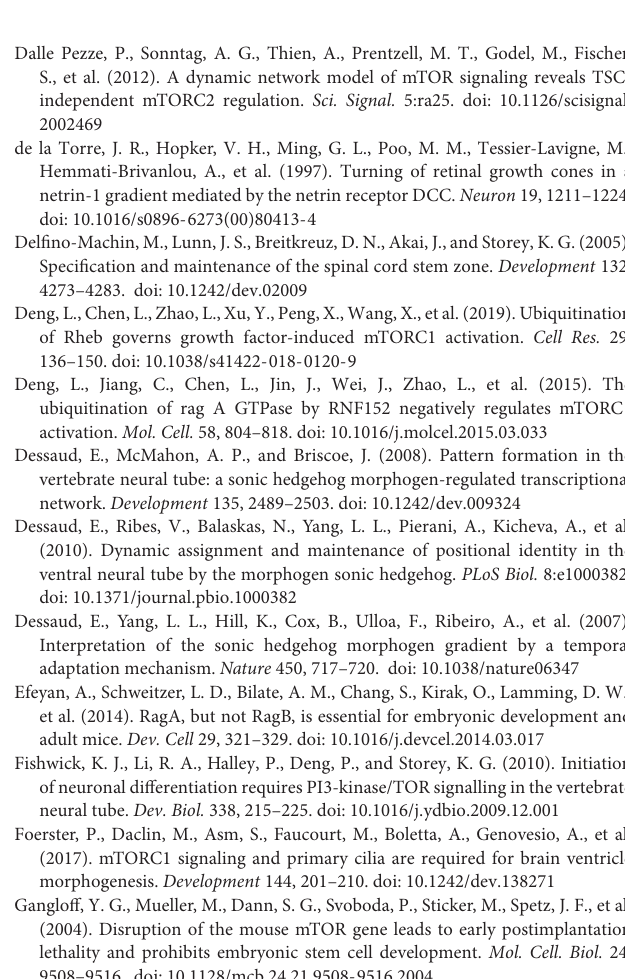
FIGURE S5 | pAKT is localized at the apical domain and at commissural neurons. pAKT-positive cells are identified by immunofluorescence in chick neural tube sections HH stages 11 (A) , 16 (B) , and 22 (C) . Expression in the apical domain, in the commissural axons and in the dorsal interneuron are indicated by white arrowheads, white arrows and green arrowheads, respectively. Scale bar = 50 µ m. TABLE S1 | Primers for quantitative PCR. TABLE S2 | Plasmids, siRNAs and antibodies used in this study (Tabancay et al., 2003; Li et al., 2004; Kim et al., 2008; Sato et al., 2008; Grabiner et al., 2014; Sasai et al., 2014; Yatsuzuka et al.,